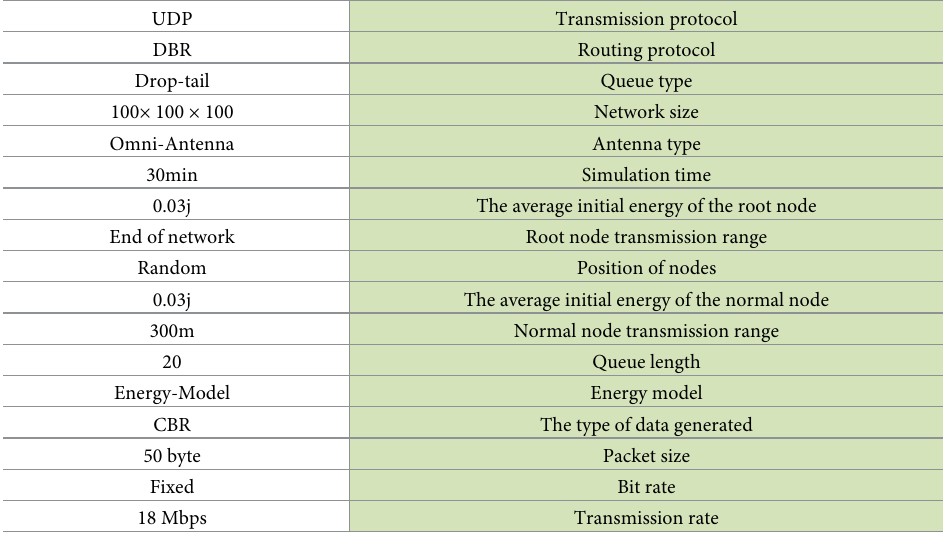
Table 3. Simulation